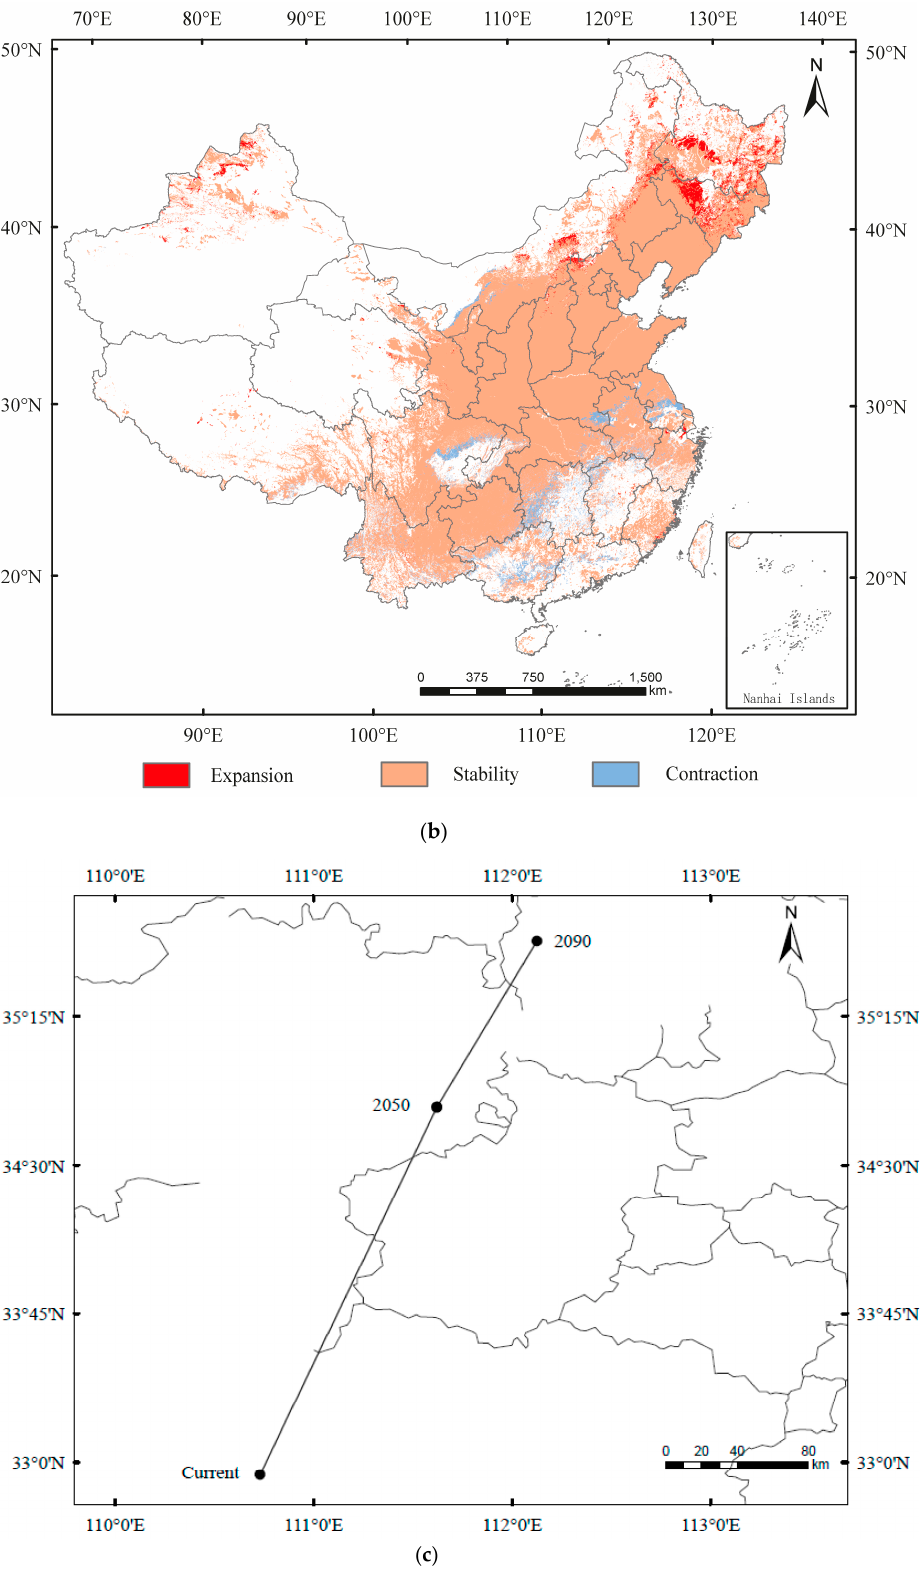
Figure 7. Spatial transfer characteristics of Dendrocopos major in ( a ) current–2050 and ( b ) 2050–2090 stages and ( c ) centroid transfer trajectory in